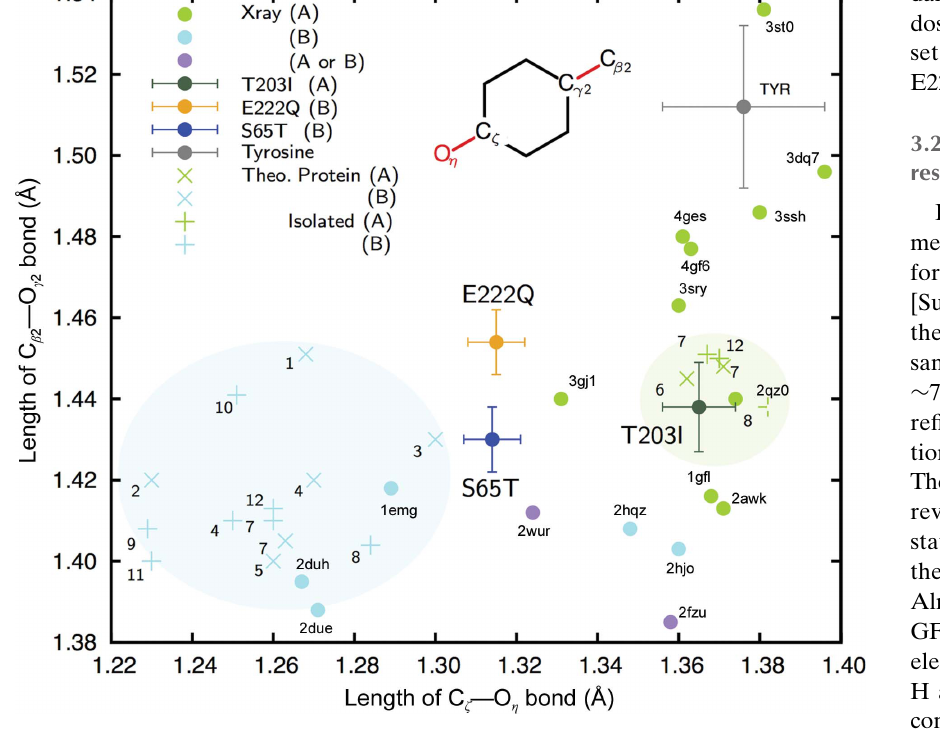
Figure 4 Relationships between the C (cid:9) —O (cid:10) and C (cid:3) 2 —C (cid:11) 2 bond lengths. Green, cyan and purple circles represent the lengths in GFP variants reported in the Protein Data Bank at higher resolution (<1.3 A˚ ) or referred to in theoretical studies (Supplementary Tables S2 and S3). The proteins are categorized by their reported spectrum or the estimated protonation state of O (cid:10) . Those with an absorption peak at a shorter wavelength ( (cid:2) 400 nm) or a protonated O (cid:10) are considered to be A-form proteins (green), while those with an absorption peak at a longer wavelength ( (cid:2) 480 nm) or a deprotonated O (cid:10) are considered to be B-form proteins (cyan). Those with an ambiguous interpretation are shown in purple. The lengths for the structures in this study (T203I in dark green, S65T in blue and E222Q in yellow) are represented with error bars of the standard deviations as estimated with SHELXL and MoPro . Those of tyrosine are shown in the same manner with the standard deviation for the restraint. Bond lengths optimized by theoretical calculation with or without consideration of the protein environment (‘Theo. Protein’ or ‘Isolated’) are shown as ‘ (cid:3) ’ and ‘+’, respectively. The numbers indicate the references listed in Supplementary Table